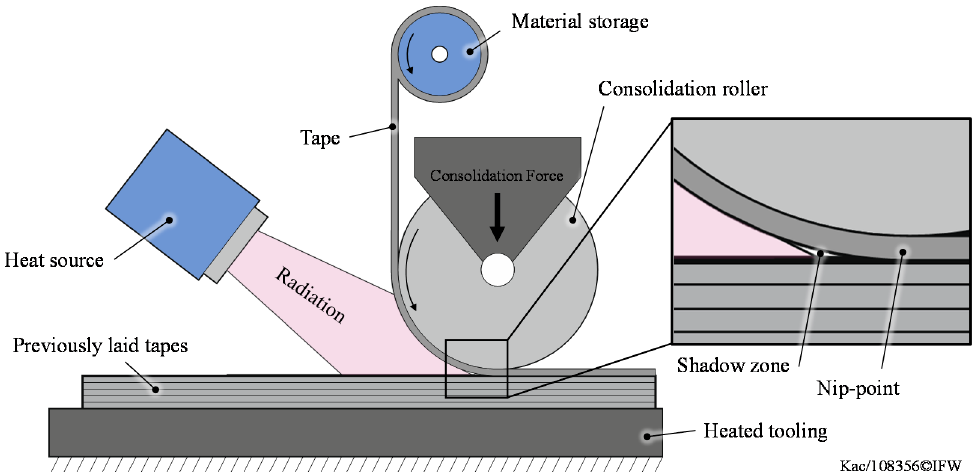
Figure 1. Schematic illustration of the laser-based Thermoplastic Automated Fiber Placement (TAFP) technology including the appearing shadow zone in front of the Nip-point.